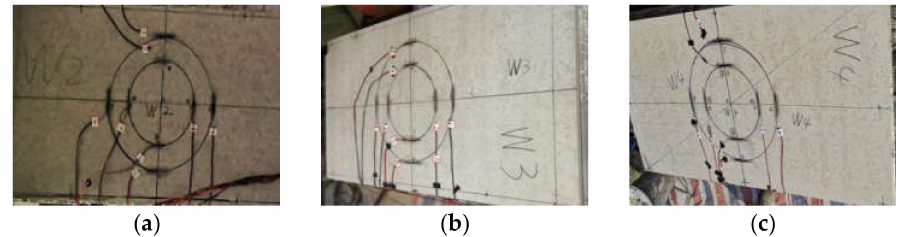
Figure 11. Damage diagrams of W2, W3 and W4 specimens after being impacted. ( a ) W2; ( b ) W3; ( c )